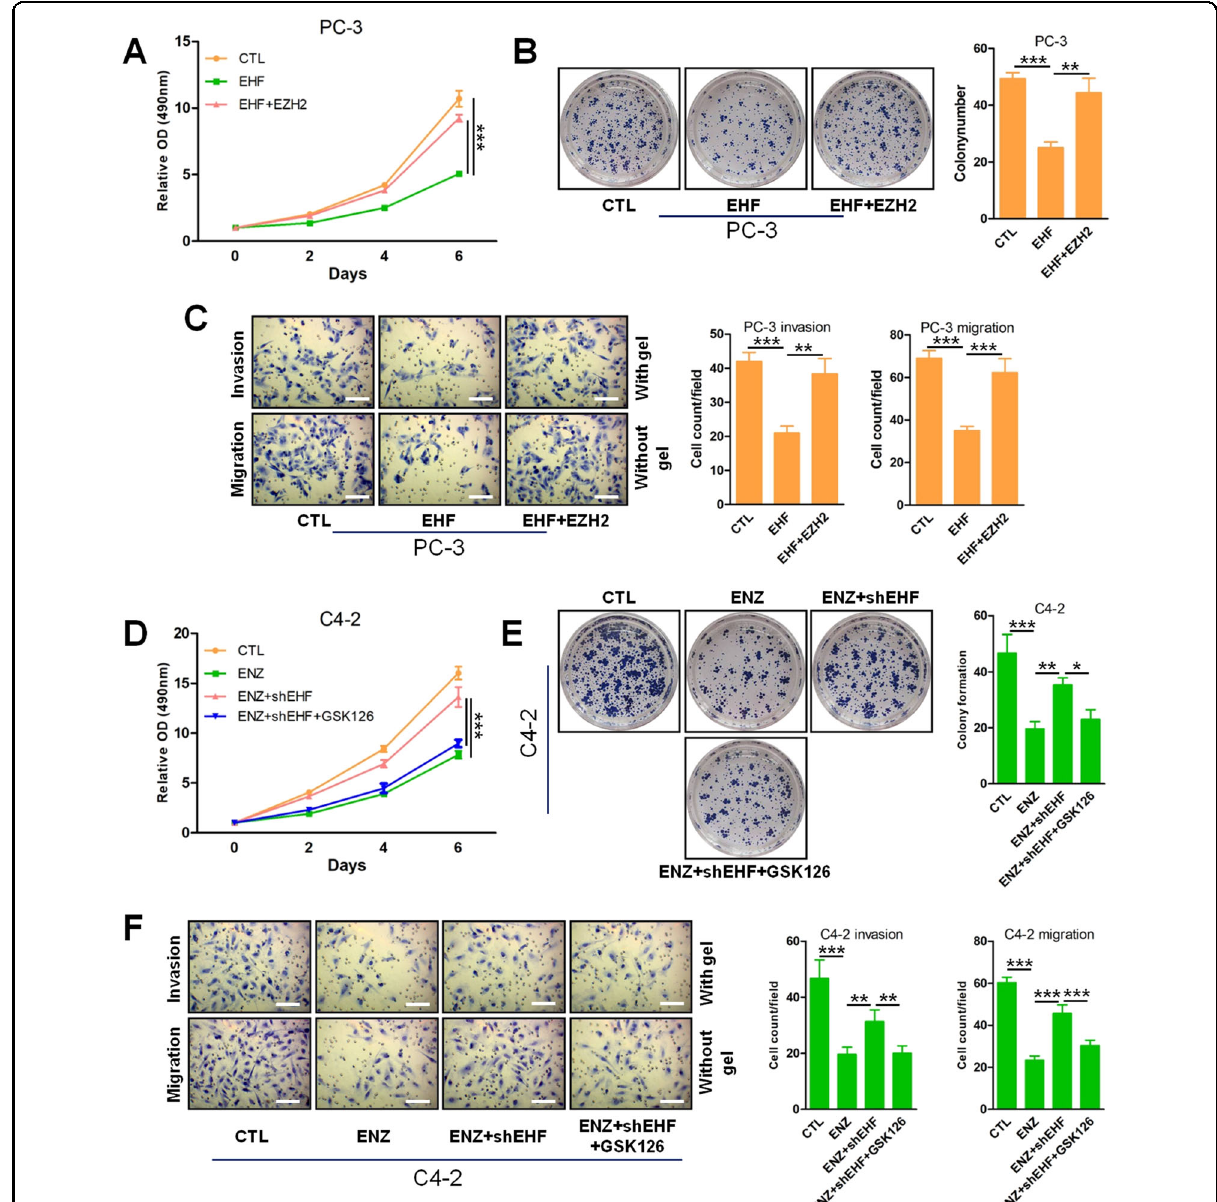
Fig. 5 EHF knockdown promotes the aggressive properties of PCa cells. A MTS assays measured cell proliferation of PC-3 cells with/without EHF overexpression and PC-3 cells with EHF and EZH2 overexpression. B Same cells as in ( A ) were used to perform colony formation assays. Representative images are shown. C Same cells as in ( A ) were used to perform cell invasion and migration assays in transwell chambers with/without coating with Matrigel. Representative images are shown. Scale bar 100 μ m. D C4-2 cells with/without EHF knockdown were treated with/without ENZ (10 μ M) and GSK126 (5 μ M), and cell proliferation was determined by MTS assays. E Colony formation assays were performed in the same context as in D . Representative images are shown. F Cell invasion and migration assays were performed in the same context as in D . Representative images are shown. Scale bar 100 μ m. One-way ANOVA, followed by Dunnett ’ s t test was used to compare results between two groups with * denoting p < 0.05, ** denoting p < 0.01 and *** denoting p < 0.001. Experiments were performed with three biologically independent samples. Bar graphs show means ± SD. OD optical